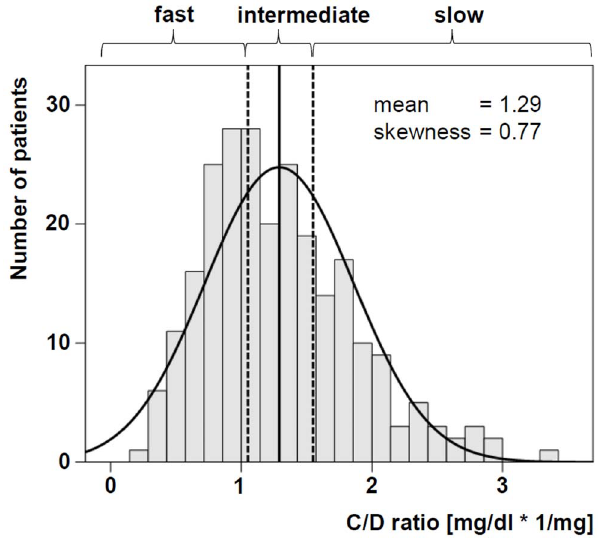
Figure 1. Histogram of the distribution of the Tac C/D ratio (ng/ mL*1/mg). The patients showed a symmetric distribution relating to their C/D ratio and were categorized in three groups: slow, intermediate and fast metabolizers. Intermediate metabolizers were grouped around the mean C/D ratio value (1.05–1.54). Patients showing a C/D ratio , 1.05 were defined as fast metabolizers, $ 1.55 as slow